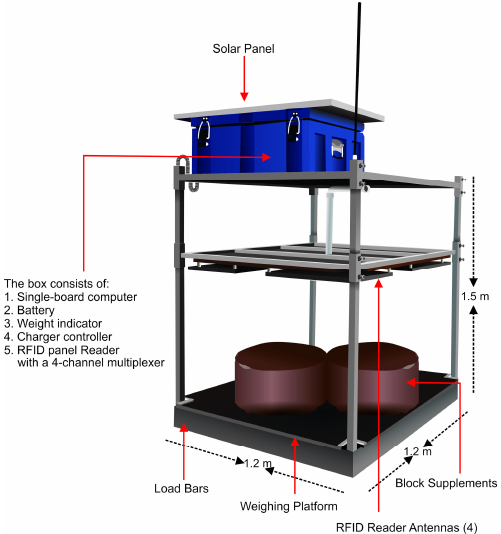
Figure 2. The layout of the automatic supplement weighing (ASW) unit.